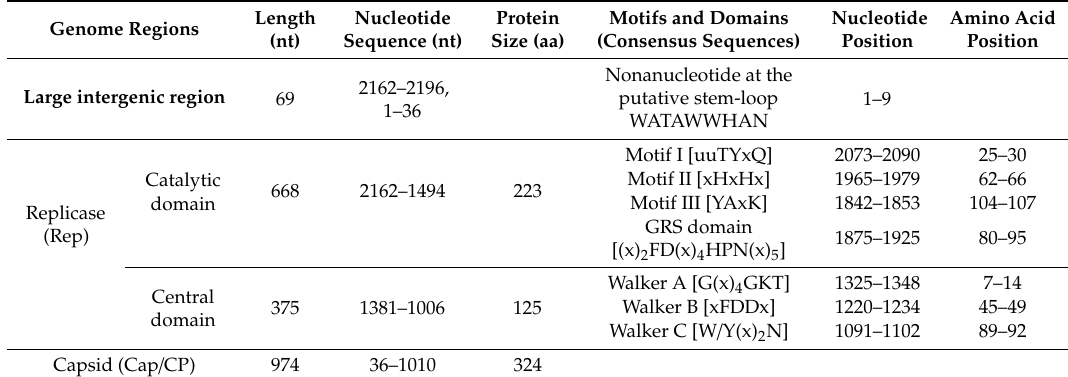
Table 3. Main genomic features and putative proteins of the novel Tadarida brasiliensis gemykibivirus 1. Length Genome Regions